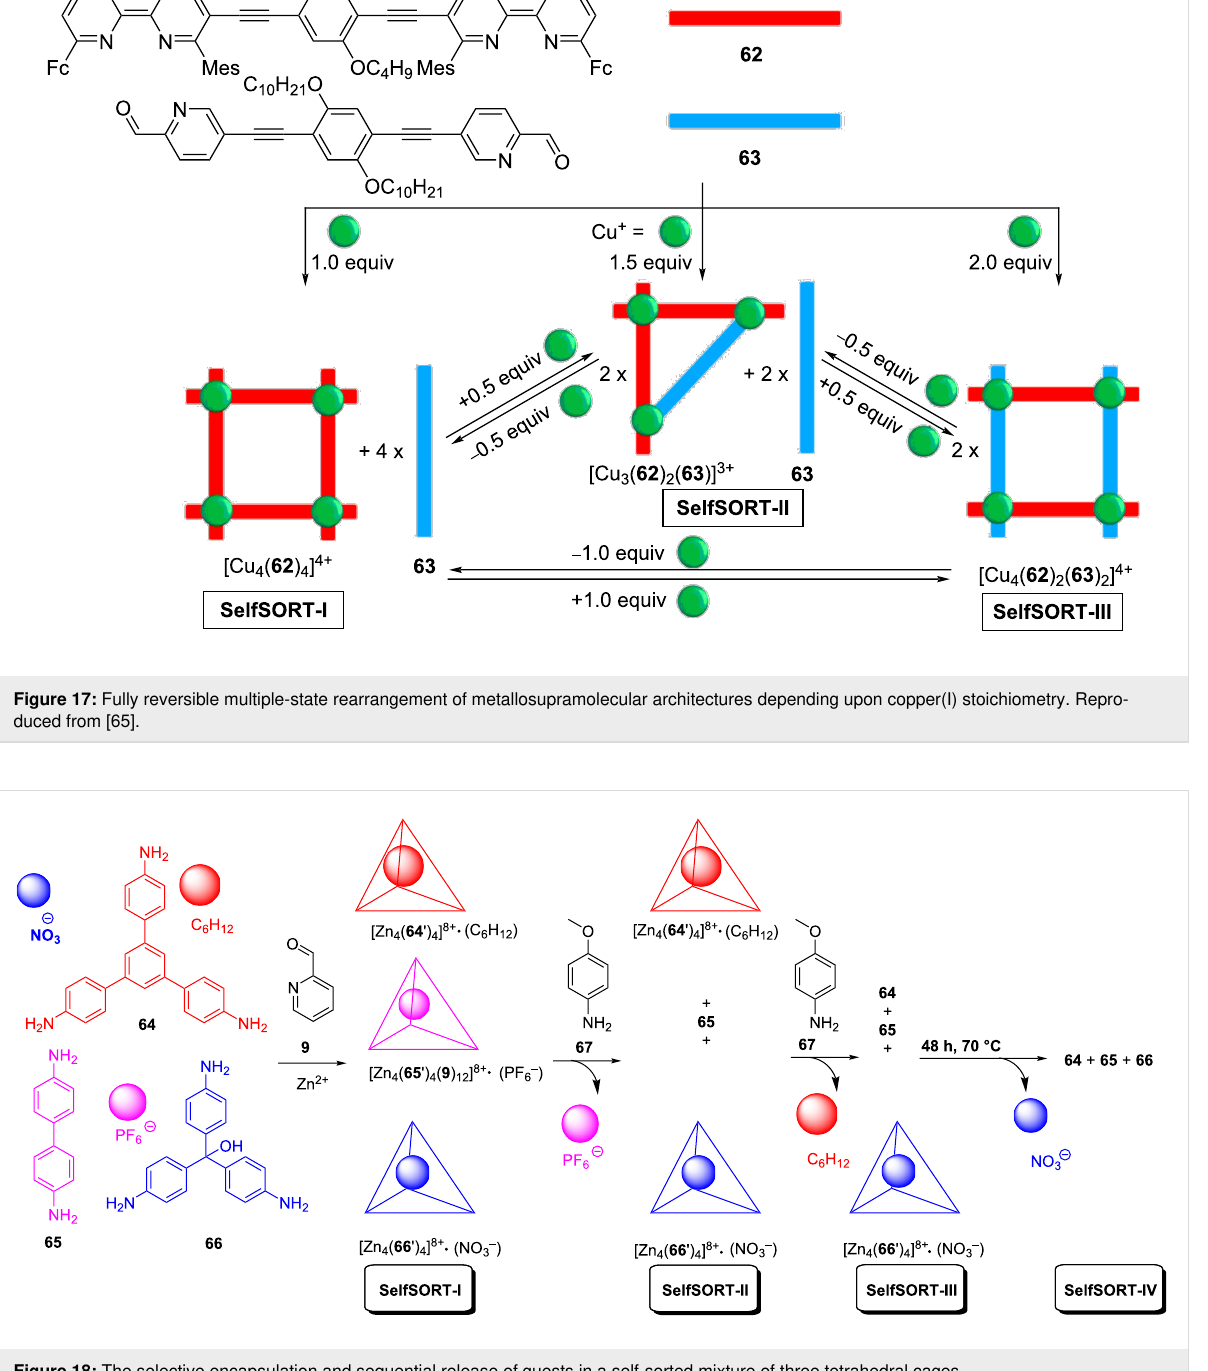
which phenanthroline 69 reacted with the intramolecular com- plex [Cu( 68 )] + generating the intermolecular complex [Cu( 68 )( 69 )] + . As a result the toggling arm in [Cu( 68 )] + had to move to the zinc porphyrin station affording [Cu( 68 )( 69 )] + .